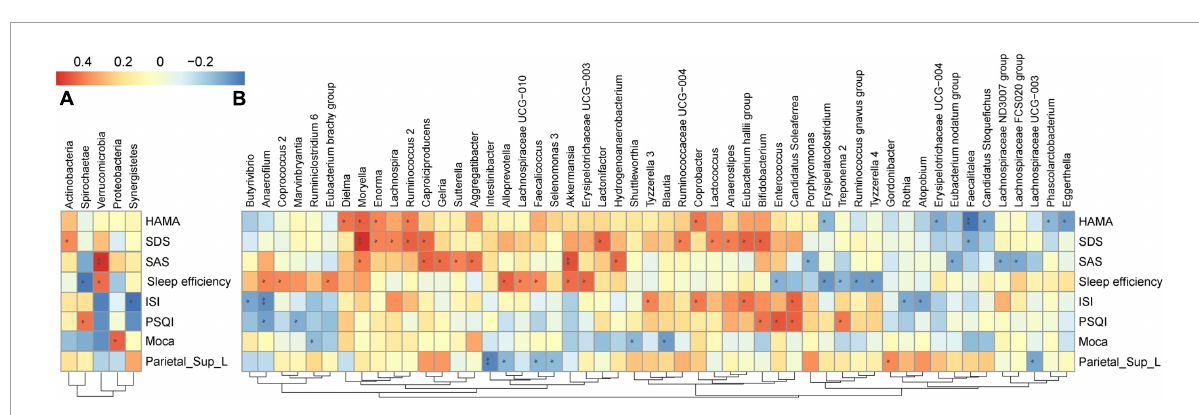
FIGURE6 Heatmap of the associations between GM and altered brain FCS and neuropsychological performances in CI patients. Heat maps at the phylum level (A) and genus level (B) demonstrate the correlation coefficients between these variables. Blue, negative correlation; red, positive correlation. * p < 0.05, ** p < 0.01. GM, gut microbiota; FCS, functional connectivity strength; CI, chronic